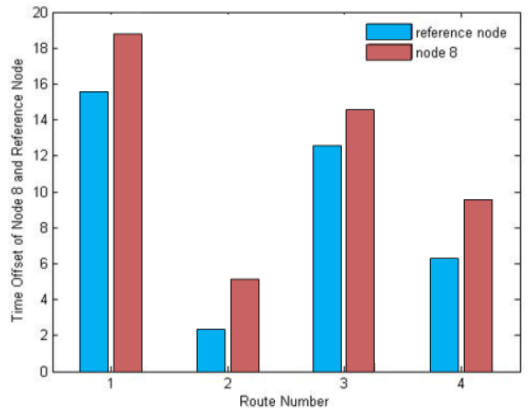
ff set of node 8 and its reference of each route. Figure 10. Time offset of node 8 and its reference of each route. Figure 10. Time o